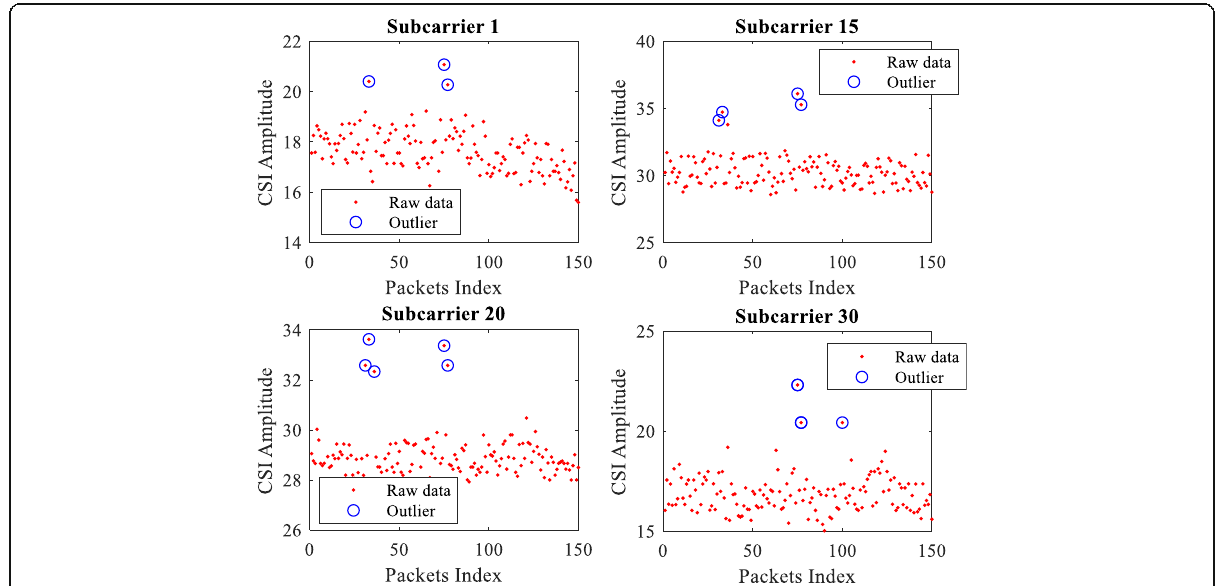
Fig. 3 Outlier removal. Each red point in this figure denotes the CSI amplitude of the subcarrier of each packet, and the blue circle is the outlier found by applying Pauta